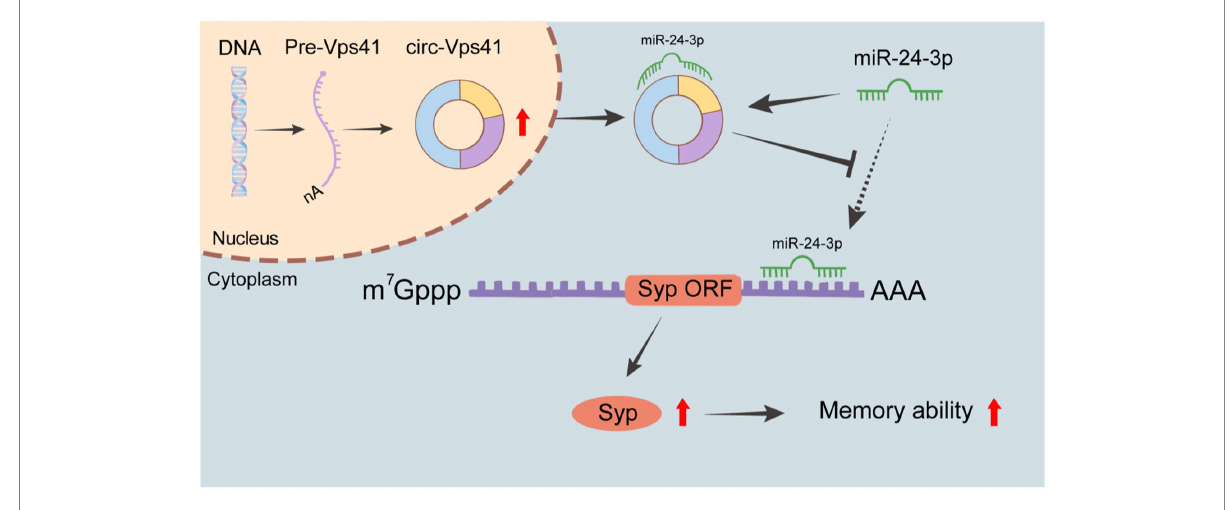
FIGURE 7 Schematic representation of the molecular mechanisms. circ-Vps41 acts as a competitive endogenous RNA and regulates the expression of Syp by sponging miR-24-3p, ultimately improving the learning and memory of aging